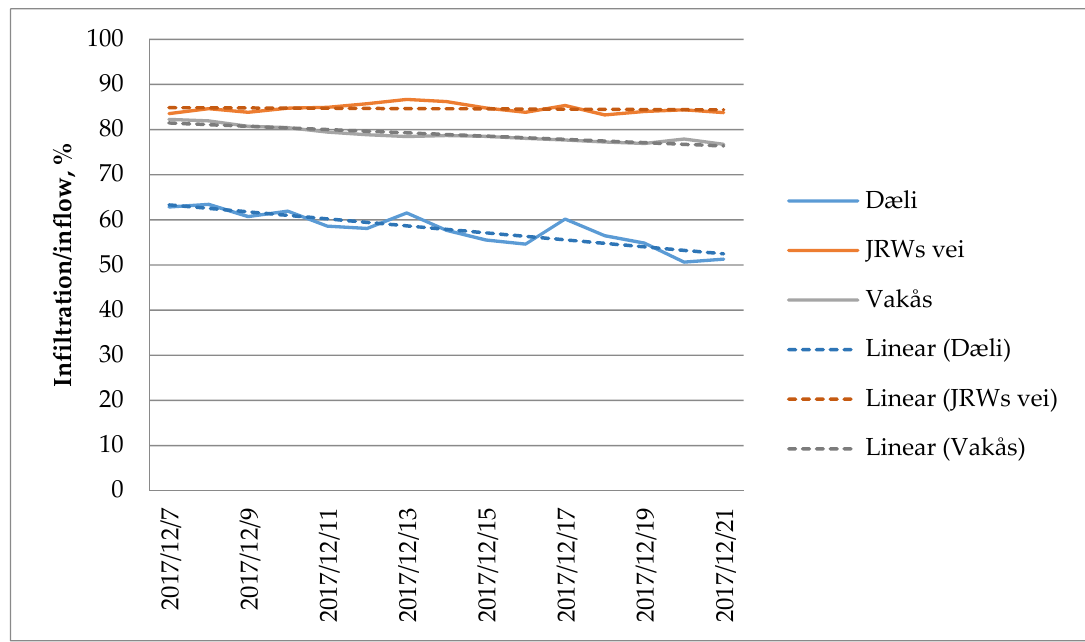
Figure 5. Calculated share of I/I-water in a dry weather period, before the implementation of the measures. Figure 6 shows dry weather periods after the implementation of the measures.